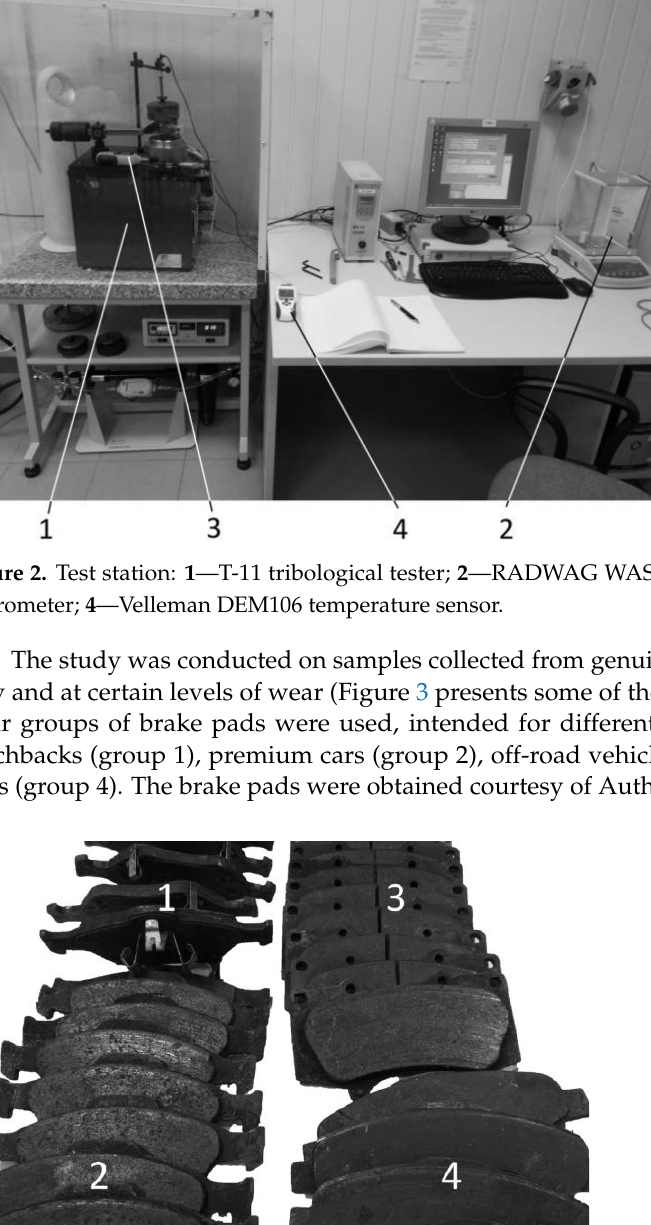
Figure 3. Examples of brake pads used for sampling: 1 — brake pads for small urban hatchbacks; 2 — brake pads for premium cars; 3 — brake pads for off-road vehicles; 4 — brake pads for delivery vans.